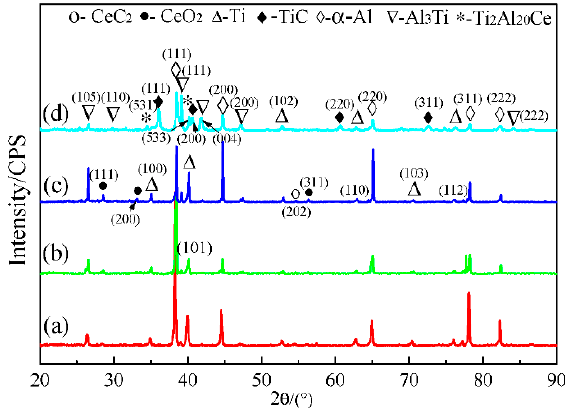
Figure 4. XRD patterns of pressing blocks at 60 s of: ( a ) 2#; ( b ) 3#; ( c ) 4#, and ( d )